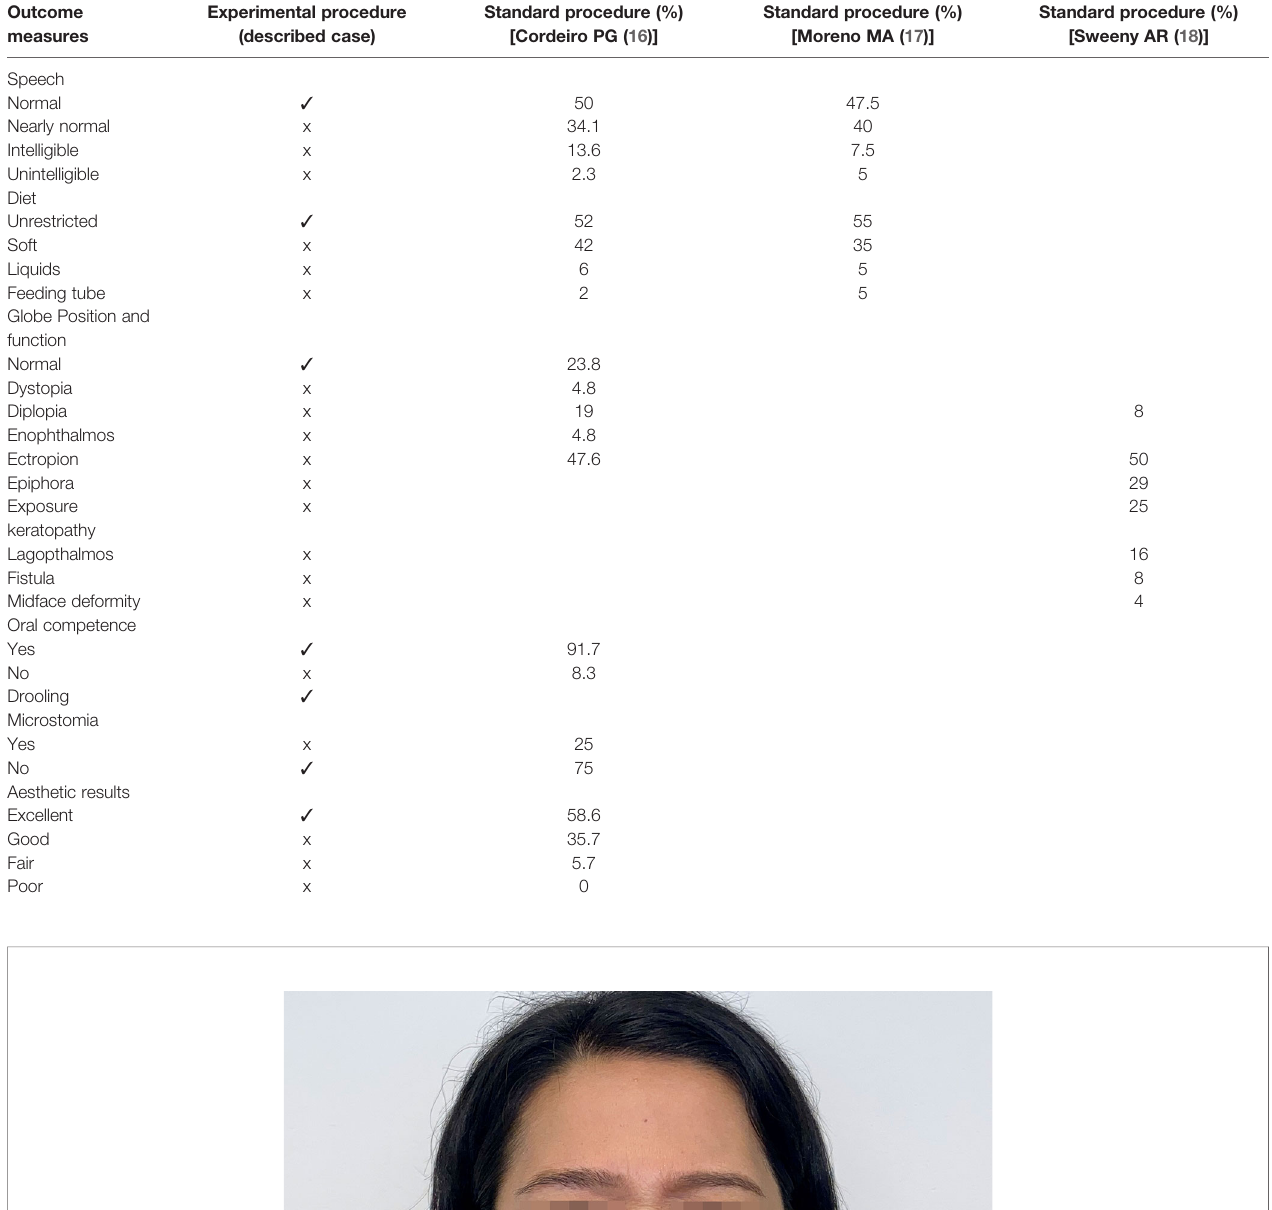
TABLE 1 | Comparison of the functional outcome between standard of care with autologous tissue transfer and experimental procedure. Outcome measures